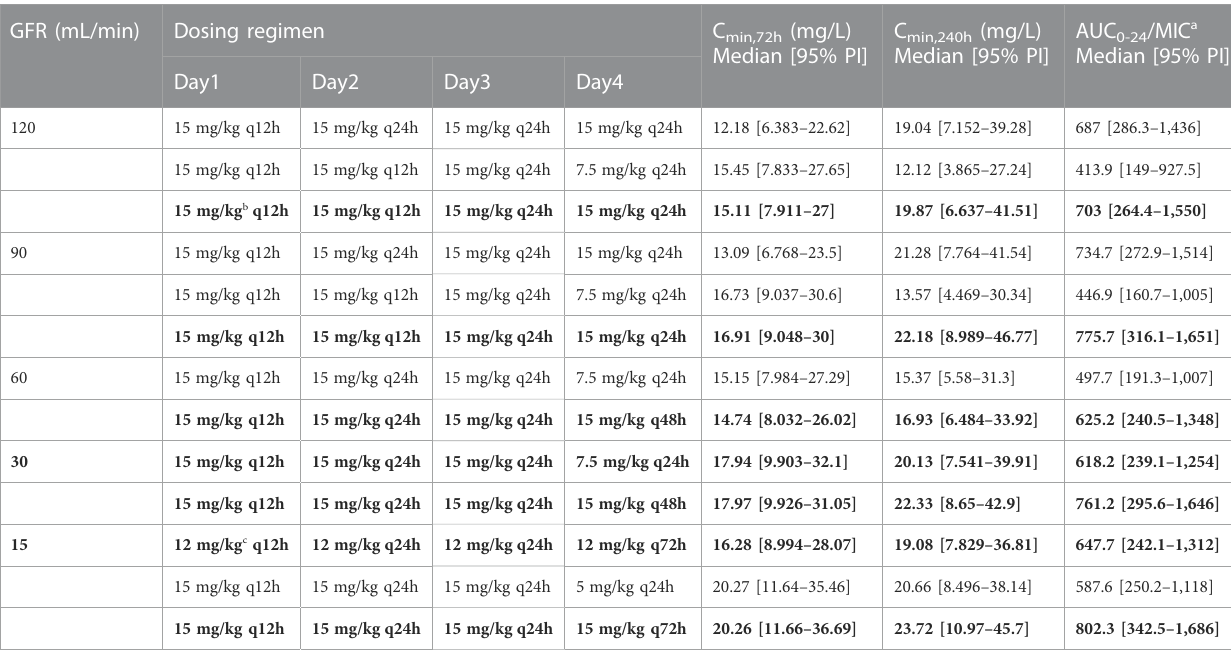
TABLE 3 Monte Carlo simulation results strati fi ed by GFR. GFR